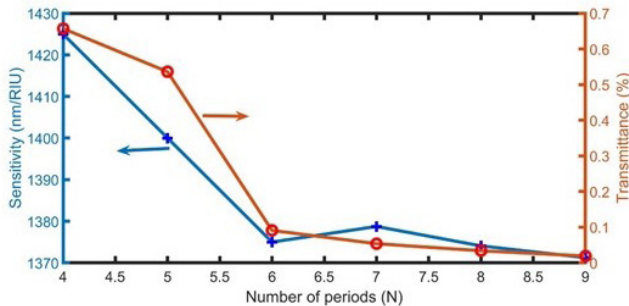
=12000 nm, and N=7. 3